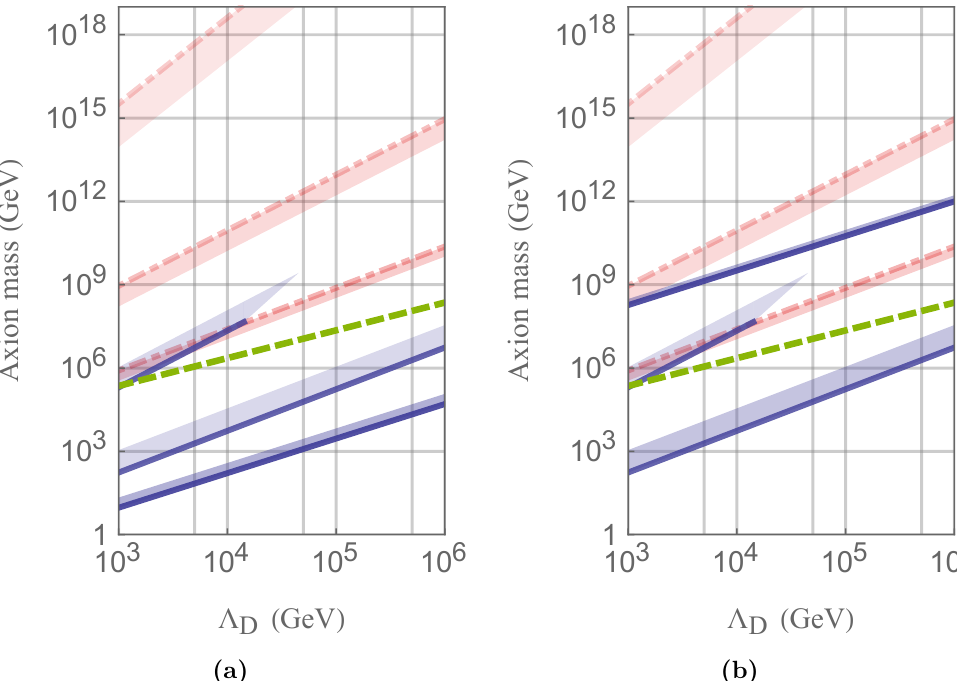
Figure 5. The physical axion mass m a (blue) as a function of Λ D , assuming y 0 i = 0 . 1 , α 0 (Λ HC ) = u,d 0 . 7 , and N = 3 , 4 and 6 (from top to bottom in the left figure, and middle, bottom, and then top in the right figure). The blue bands indicate the axion mass with α 0 (Λ HC ) varying from 0.3 to 0.7. The physical dark axion mass m a (green, dashed) assuming α 0 (Λ HC ) = 0 . 7 for N = 6 is D also included, which is fairly insensitive to α 0 (Λ HC ) and N . For reference, the red dot-dashed lines represents the Λ HC scale determined from eq. (3.33), for N = 3 , 4 , 6 . Like the axion mass